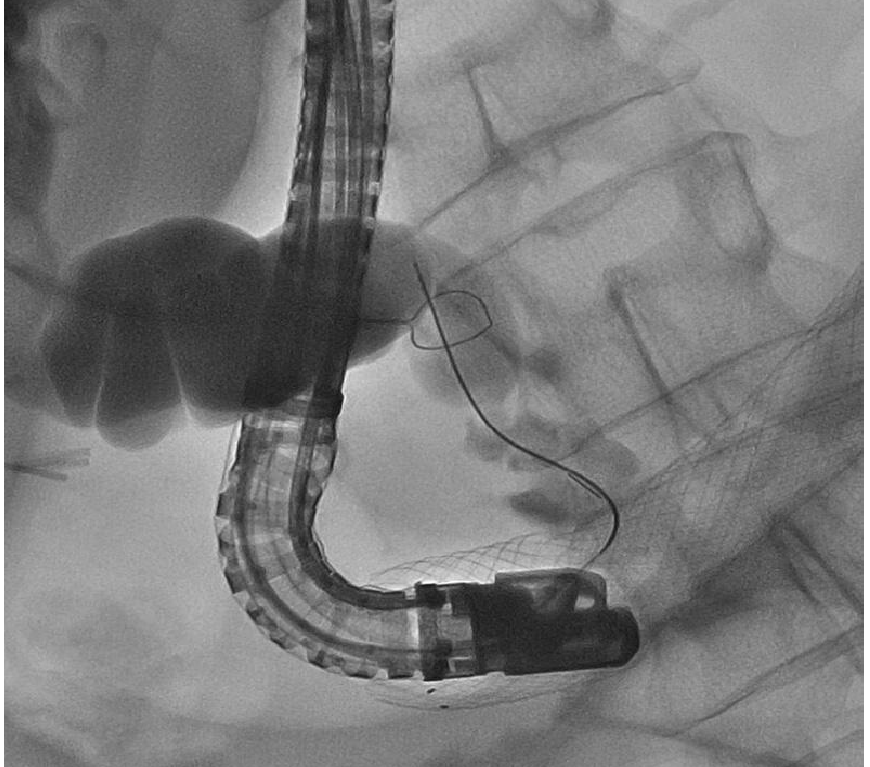
Figure 7. In this PTC image, the guidewire of the sphincterotome in the main bile duct is appreciable, while the One-Snare retrieval device, through the already present percutaneous catheter, was brought up to the guidewire itself and hooked it.